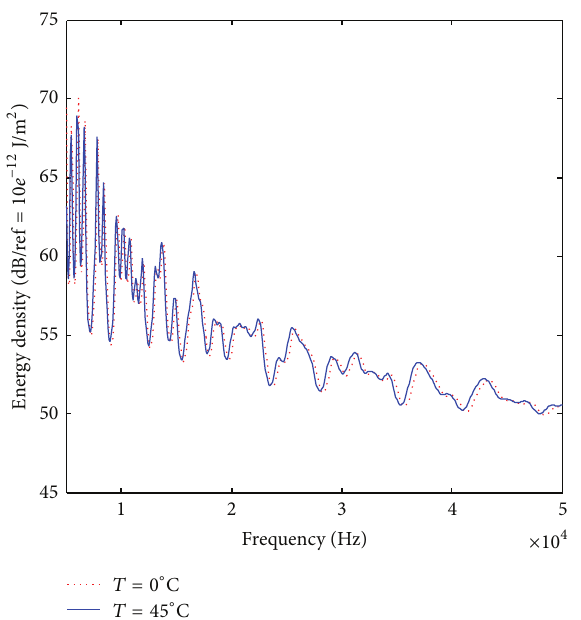
Figure 10: Averaged energy density levels by frequency with an increment of 100Hz when 𝑇 = 20 ∘ C and 𝑇 = 65 ∘ C.